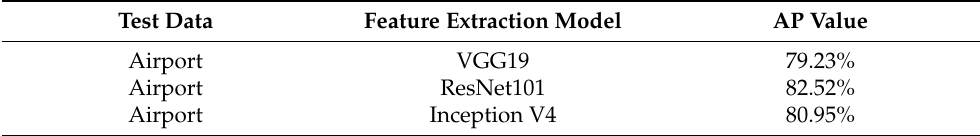
Table 3. Comparison of different feature extraction models.